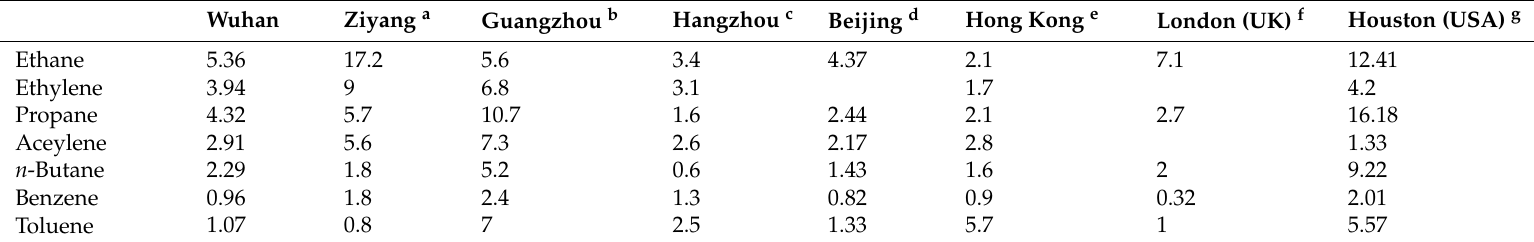
Table 3. The average concentrations of most abundant VOCs (in ppb) in Wuhan and comparison with other